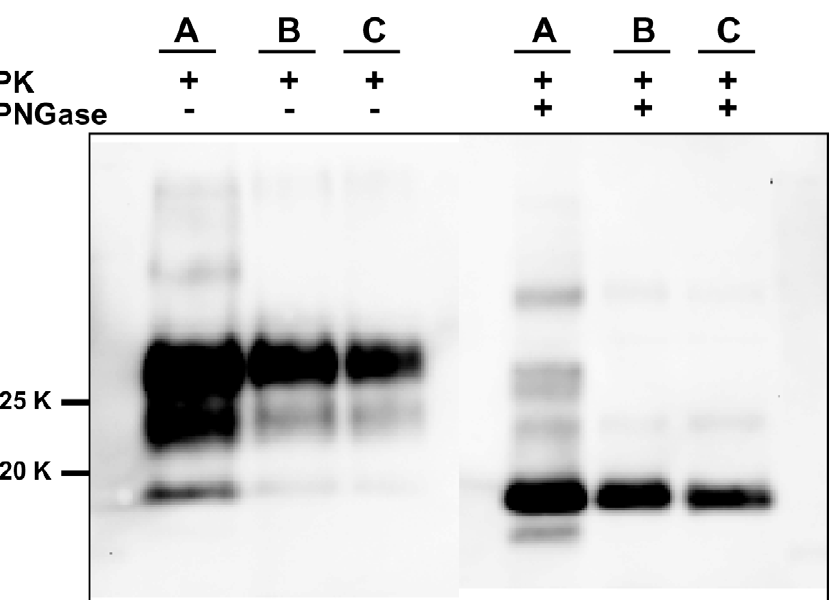
Figure 3. Comparison between PrP Sc from seeded and unseeded PMCA reactions. Characterization of PrP Sc from positive samples of the experiment described in Figure 2A by Western blot, stained with SAF84 primary antibody. The figure shows that samples A (PrP Sc from 10% brain homogenate used as positive inoculum), B (10 2 5 dilution of the inoculum after a single 24-hour round of PMCA) and C (PrP Sc from an unseeded negative control which was positive after 6 consecutive rounds of saPMCA) share the same apparent molecular weight before or after deglycosylation with PNGase.